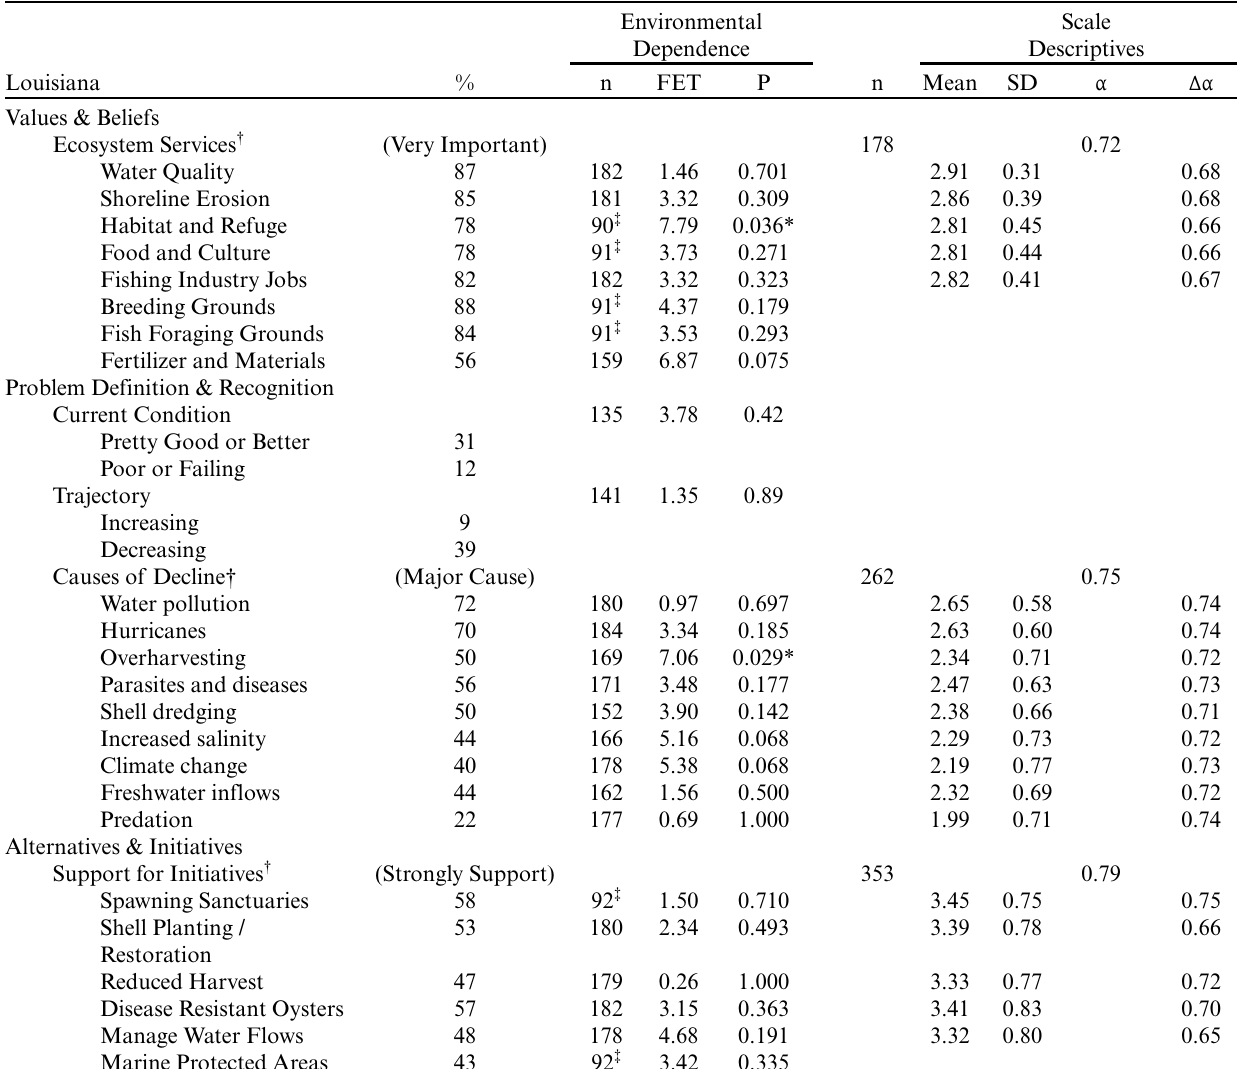
Table 3 . Scale descriptives and results of Fisher’s Exact Tests (FET) on environmental dependence for Louisiana.